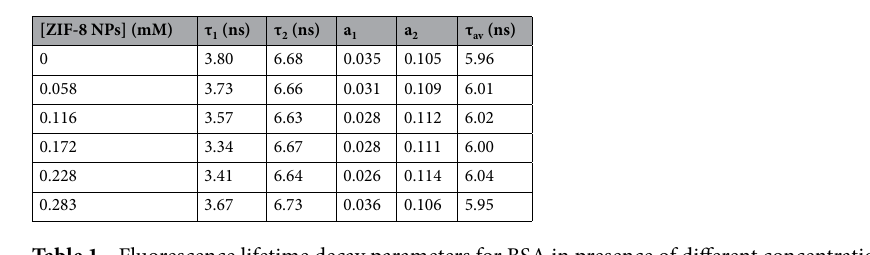
Table 1. Fluorescence lifetime decay parameters for BSA in presence of different concentrations of ZIF-8 NPs.